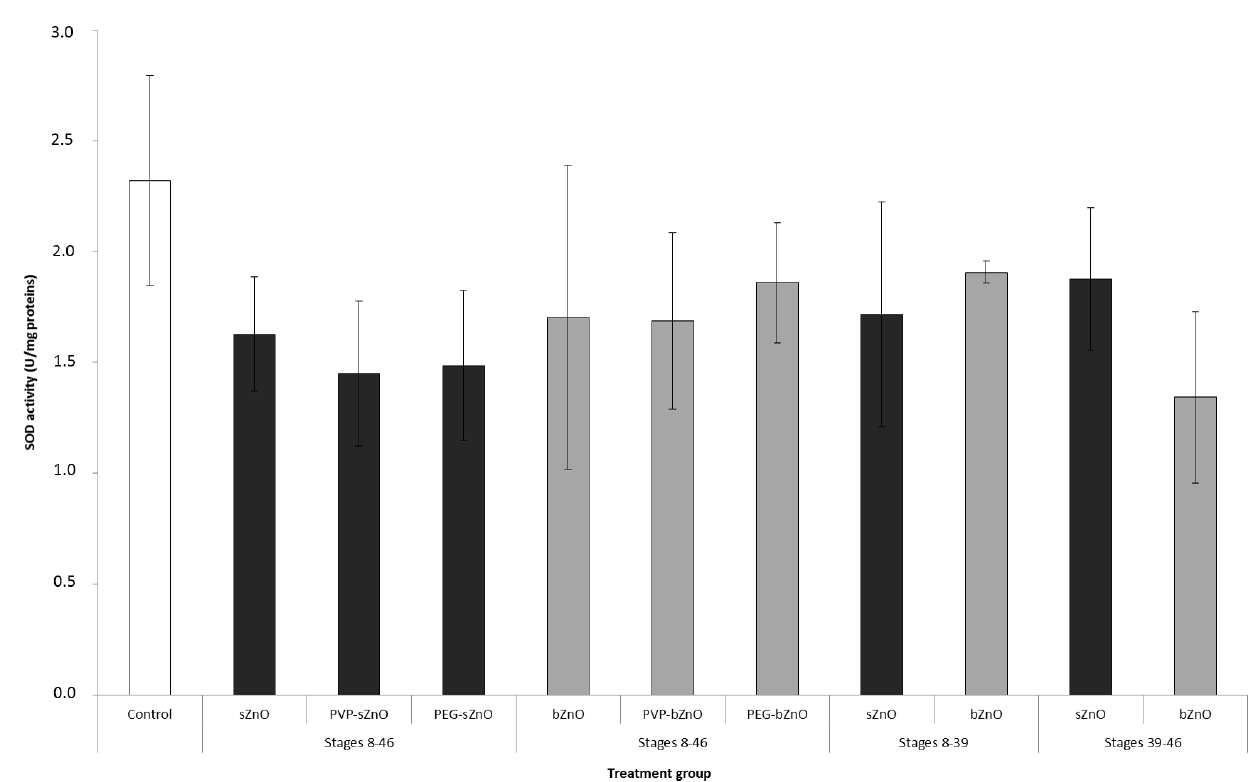
Figure 6. SOD enzymatic activity in embryos exposed to nude and polymer-coated sZnO and bZnO 50 mg/L during different developmental stages. Dark grey = sZnO-exposed larvae; light grey = bZnO-exposed